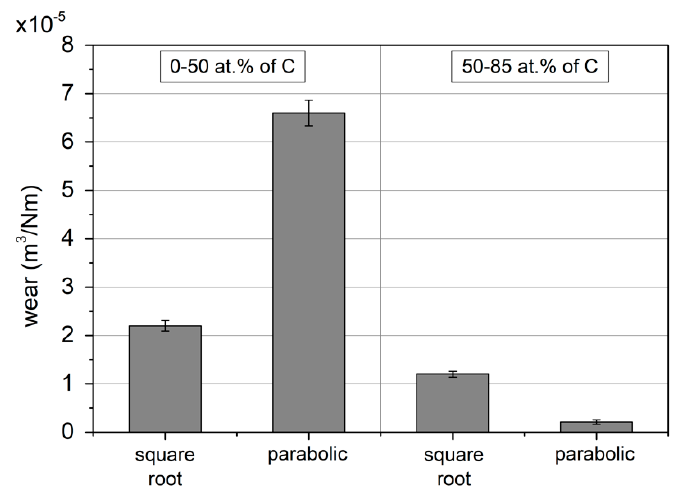
Figure 16. Volumetric wear indicator after the ball-on-disc test of gradient Zr–C coatings with various carbon content profiles.